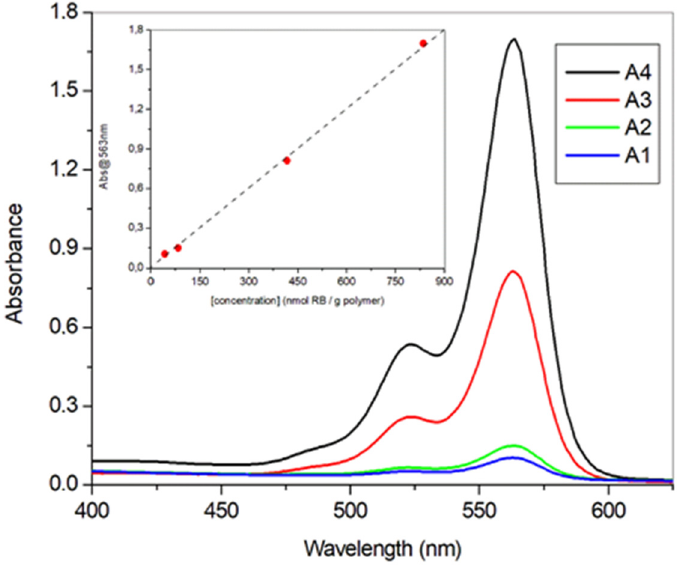
Figure 5. UV-vis absorption spectra of A1 – A4 films. Inset: absorbance at 563 nm as a function of RB loading (linear fit with R=0.9995, slope=0.00203 ± 0.00004).